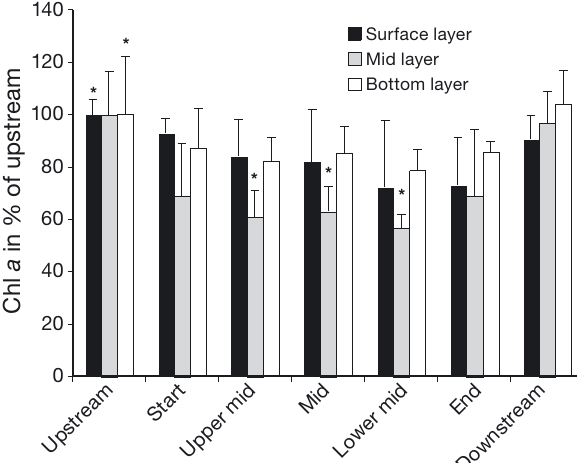
Fig. 7. Average (+SD) depletion of chl a in 3 depth layers within a mussel culture unit measured on a single occa- sion. *Significant clustering of high or low depletion rates by Getis-Ord G i